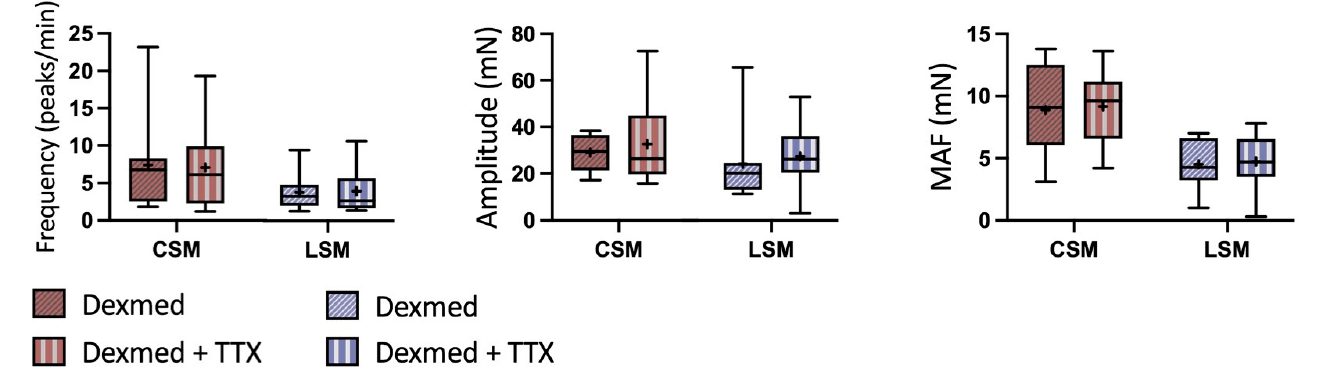
Figure 8. Box plot diagram of the basal contractile activity of jejunal circular smooth muscle (CSM) and longitudinal smooth muscle (LSM) during pre-ischaemia at time point t110 in the organ bath experiment, following treatment with dexmedetomidine (Dexmed), with and without the addition of tetrodotoxin (TTX). There were no significant differences between the treatment groups (two sample t -test). The horizontal bar displays the median and the plus is the mean, the interquartile range is represented by the box and the minimum and maximum by the whisker plots. MAF is the mean active force.